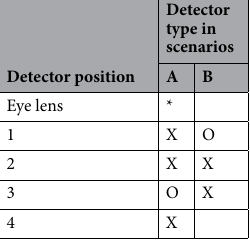
Detector type in scenarios A